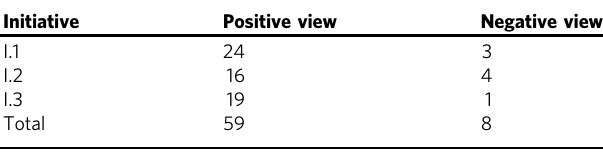
Table 8 Pupils ’ view of the subject/initiative. Initiative